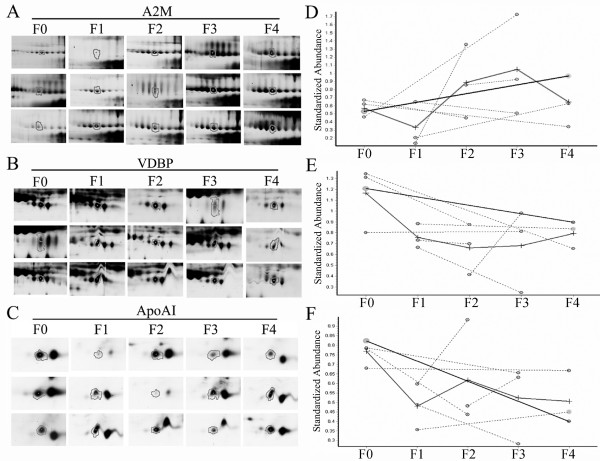
The protein expressions of A2M (A), VDBP (B) and ApoAI (C) are presented in eight gels. The expressional trends of A2M (D), VDBP (E) and ApoAI (F) were calculated with DeCyder 6.5 software. A2M is an up-regulated protein; VDBP and ApoAI are down-regulated proteins with hepatic fibrosis development.